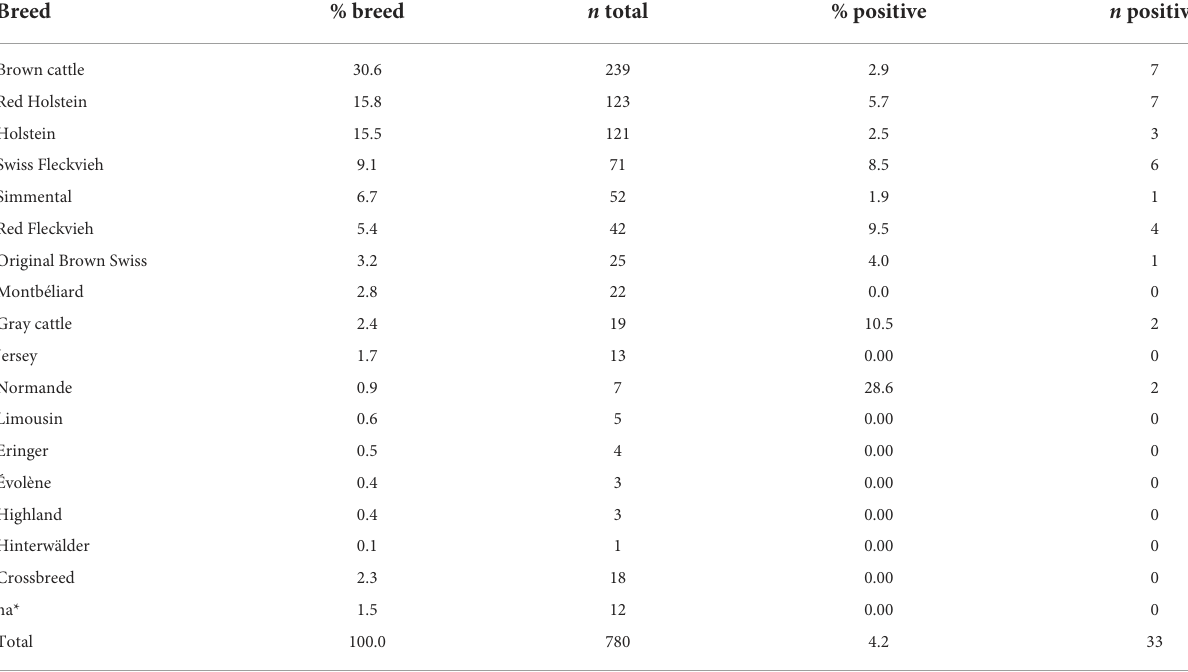
Breed % breed Brown